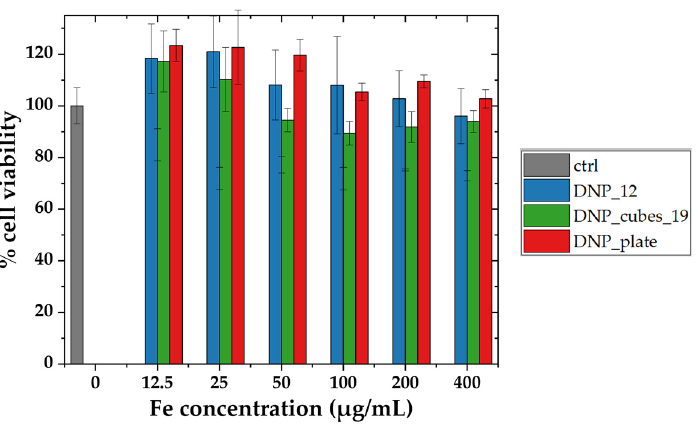
Figure 9. Cell viability of FaDu cells measured by the MTT assay as a function of iron